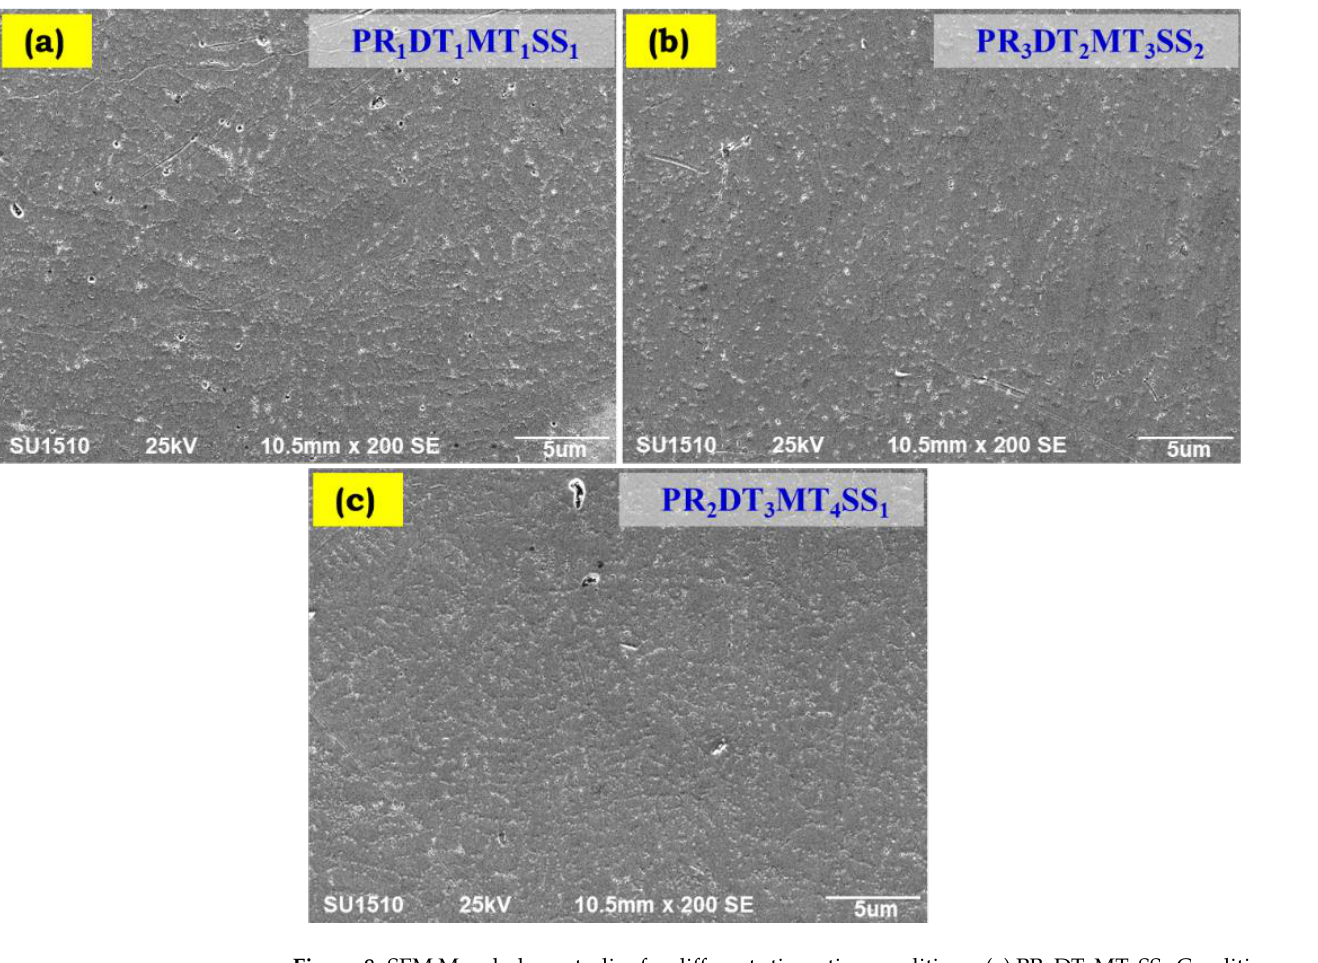
Table 11. Taguchi-CRITIC-MOORA based multiple objective optimization.